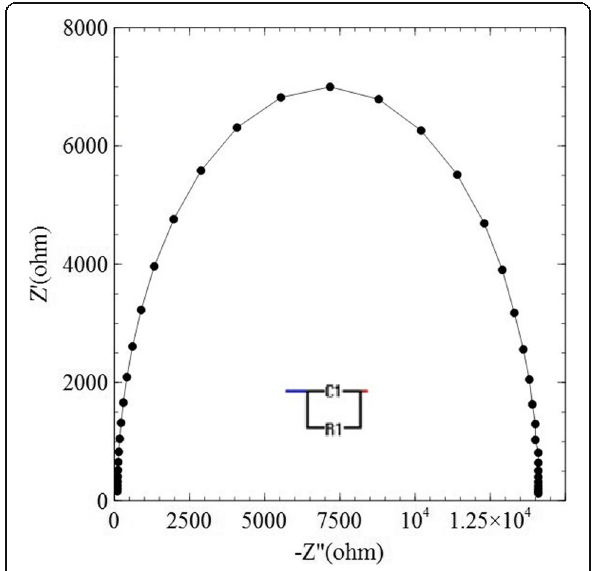
Fig. 1 Nyquist plot using sample data from EIS Spectrum Analyzer Software (Bondarenko and Ragoisha, 2005).